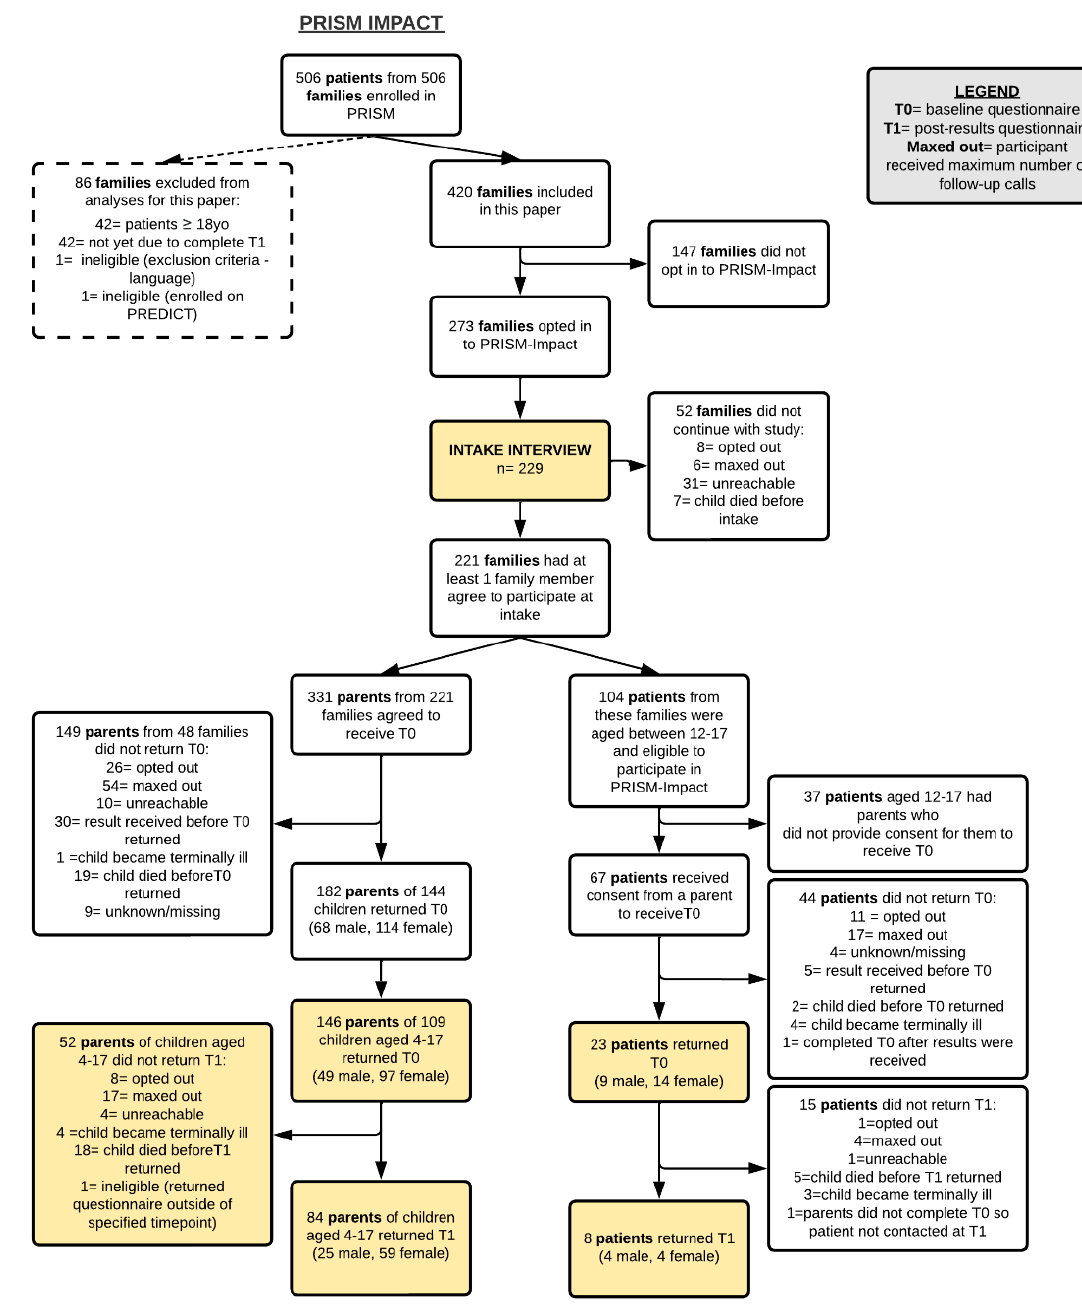
Figure 1. Participant recruitment and flow through PRISM-Impact as of 19 August 2021.